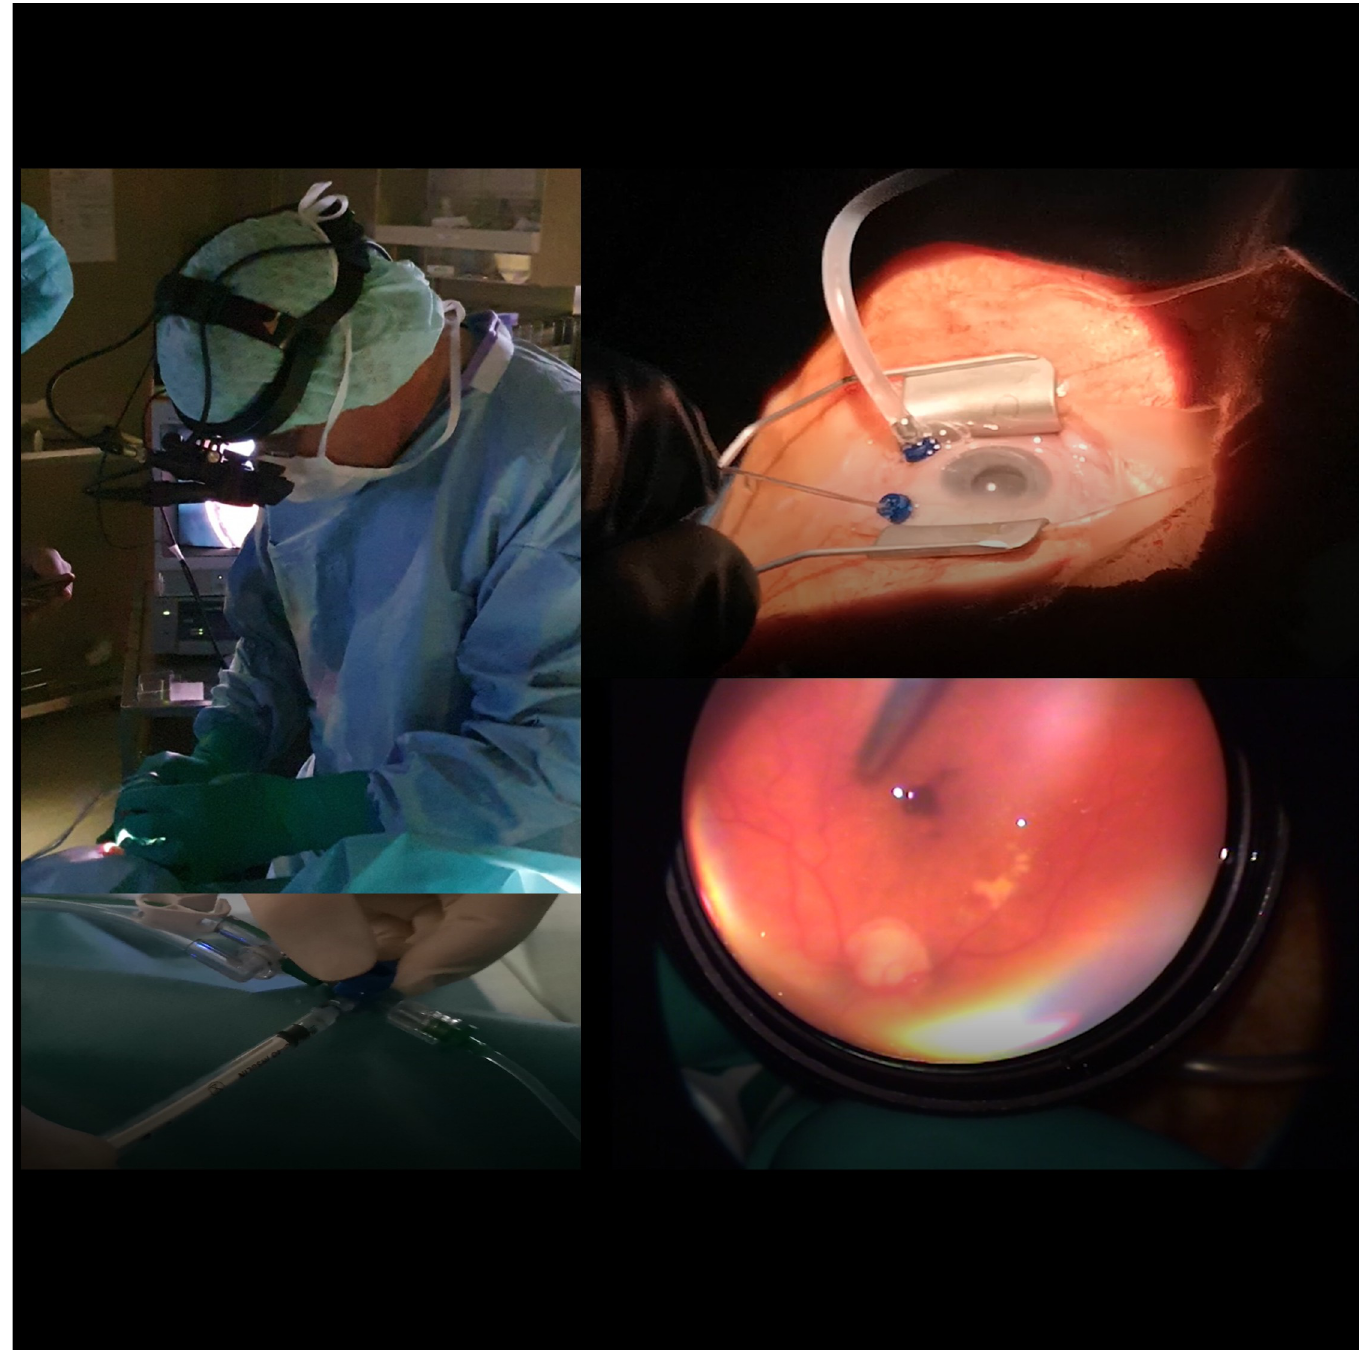
Fig 3. Pictures showing the vitreous sampling procedure during a partial vitrectomy. Image notes: (1) Top-left panel shows a picture of the surgeon performing a 2-port partial pars plana vitrectomy under control with the indirect ophthalmoscope. (2) Bottom-left panel shows the maneuver taking a vitreous probe. (3) Top-right panel shows an overview of the operative field. (4) Bottom-right panel shows the view through the indirect ophthalmoscope setup.